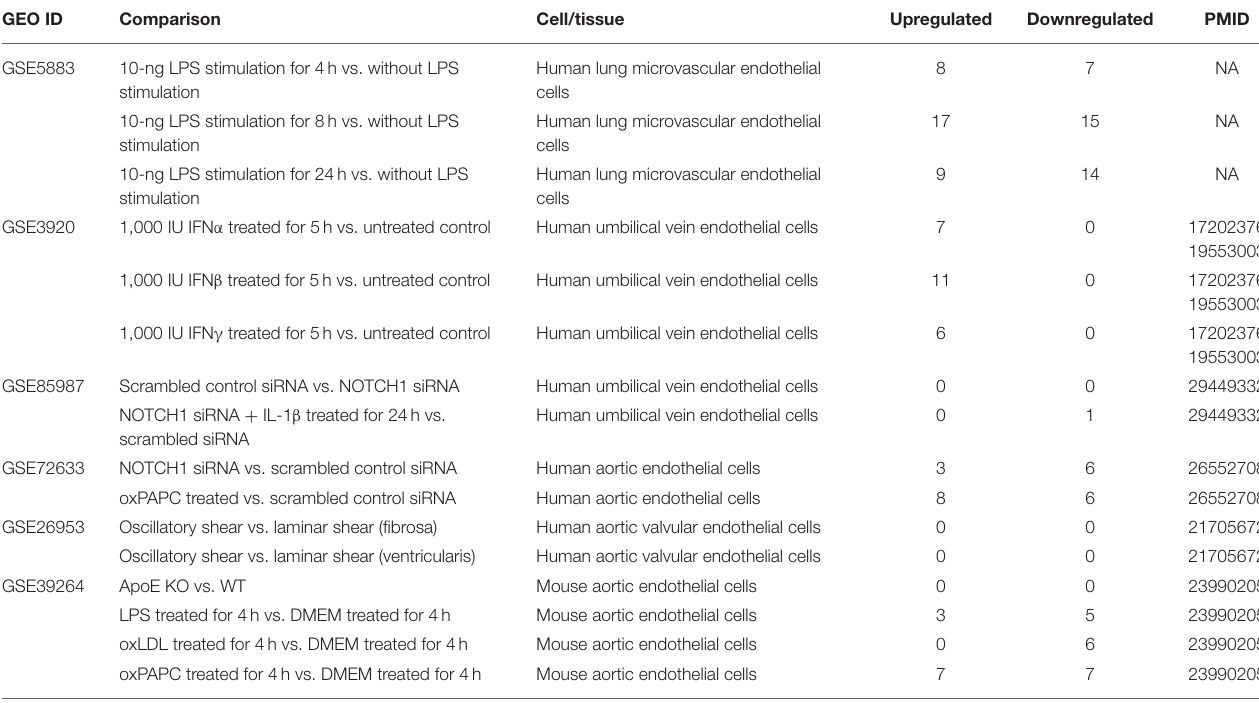
TABLE 4 | Six microarray datasets about endothelial cells in pro-atherogenic damage-associated molecular patterns (DAMPs) such as oxLDL, LPS, oxPAPC, and IFN treated conditions in the National Institutes of Health (NIH)–National Center for Biotechnology Information (NCBI)–Gene Expression Omnibus (GEO) datasets database (https://www.ncbi.nlm.nih.gov/gds/) were collected to analyze the changes of organelle interactions and vesicle-related gene.